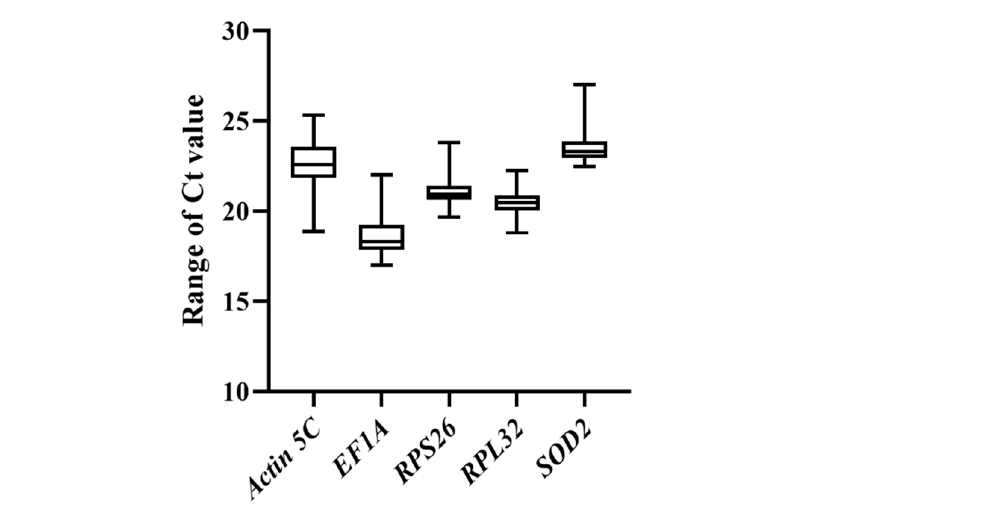
Figure 1. Ct value distribution of five reference genes in all analyzed samples of Thermobia domestica . The whiskers of the boxes are the minimum and maximum Ct values, and the horizontal lines inside the boxes are the median values.